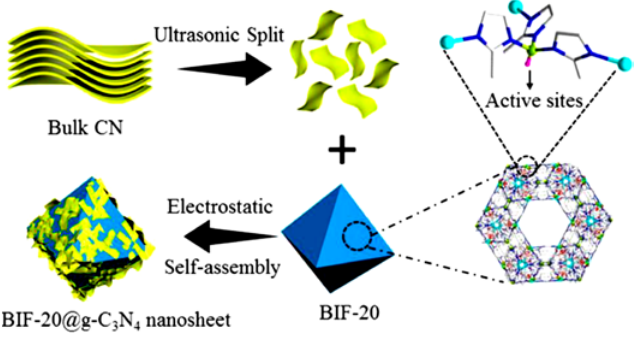
Figure 10. Schematic description of the preparation of the BIF-20@g-C 3 N 4 nanosheet photocatalyst. Reprinted with permission from